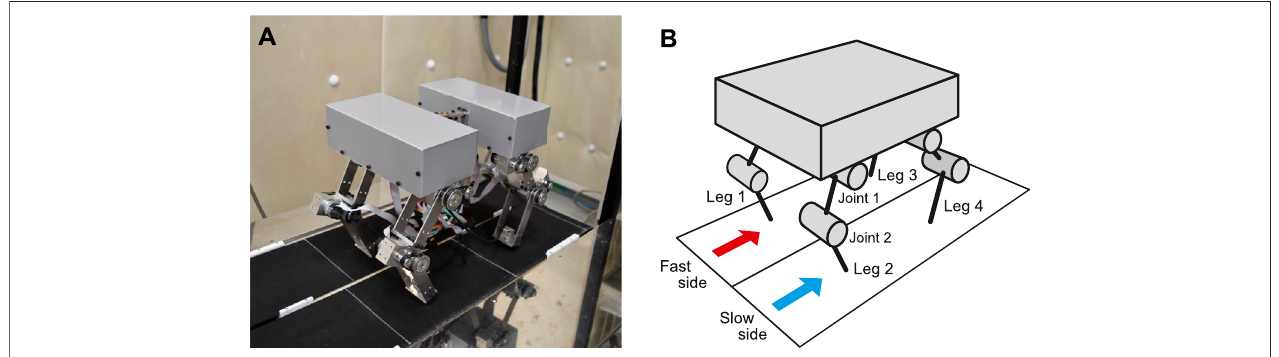
FIGURE 1 | Experimental setup. (A) Photograph of quadrupedal robot on split-belt treadmill. The robot body consists of two sections that are mechanically attached to each other. (B) Schematic model of quadrupedal robot.